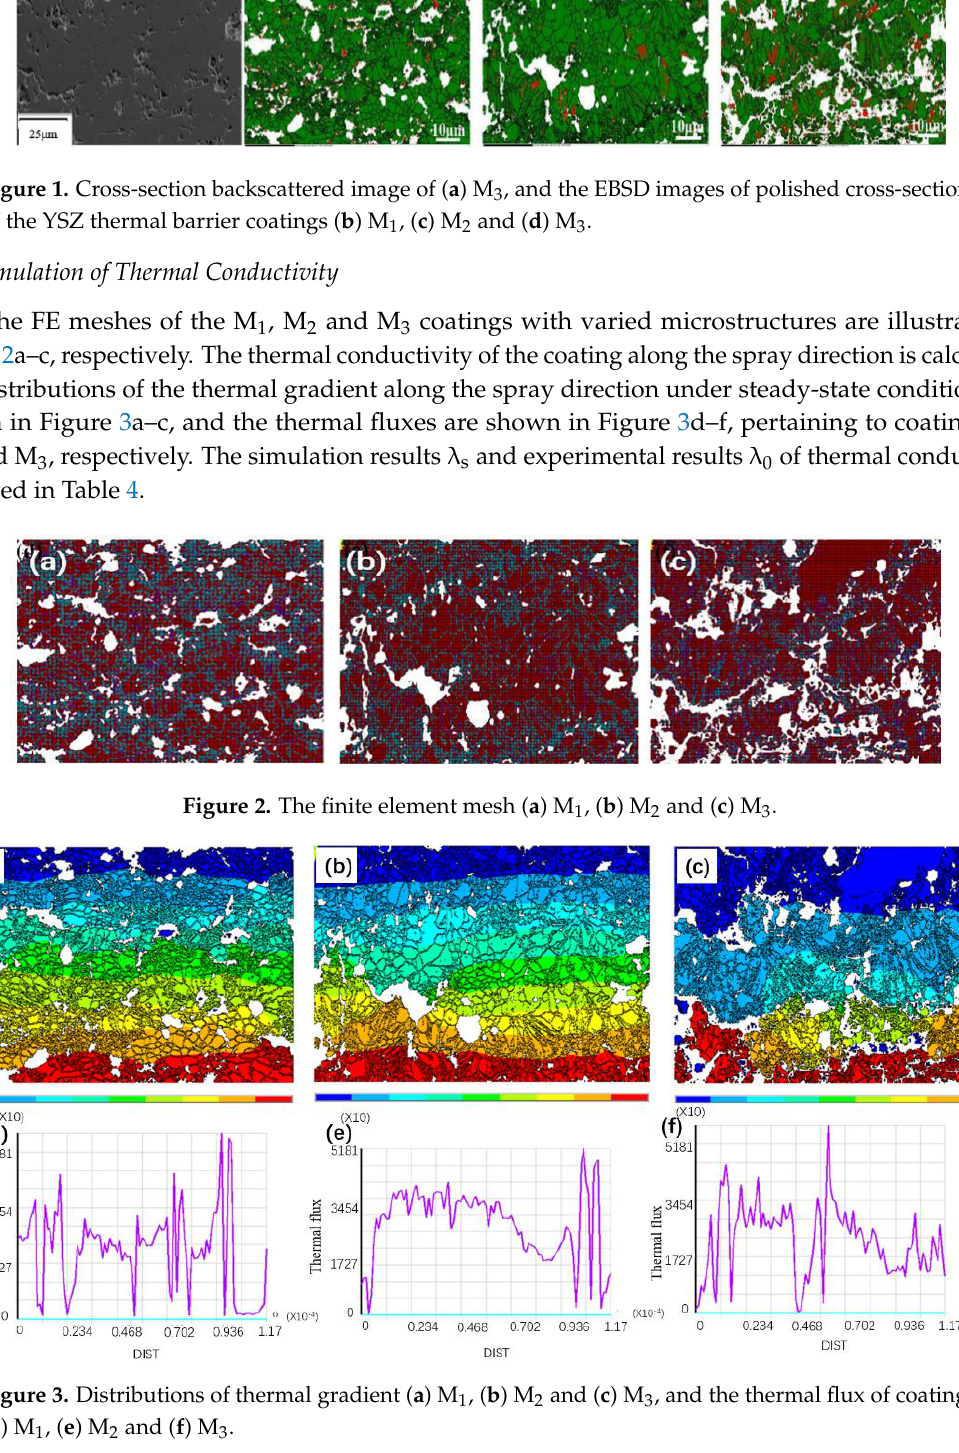
Table 3. Microstructures parameters.